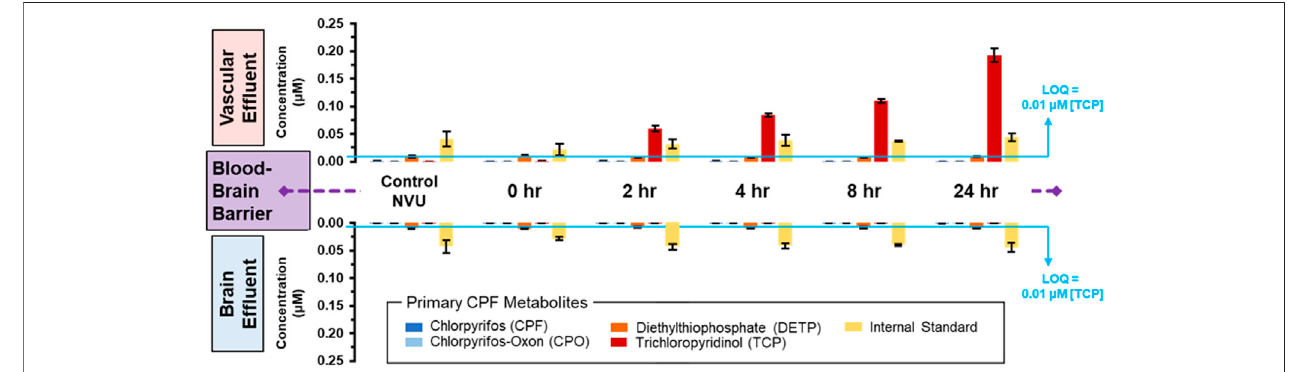
FIGURE 4 | Distribution of CPF and its three primary metabolites at and across the BBB with lengthening exposure times. Using targeted MS, CPF and its metaboliteswerequanti fi edinboththevascular( upperplots )andneuronal( lowerplots )eluatemediasamples.Thesesampleswereobtainedatlengtheningdurations ofexposureto10 µMCPFwithintheNVU.Thelimitofquantitation(LOQ)wasdeterminedfromserialdilutionsofaTCPstandard.Aninternalstandard,DtBP,wasusedto calibrate instrument response during each sample injection.